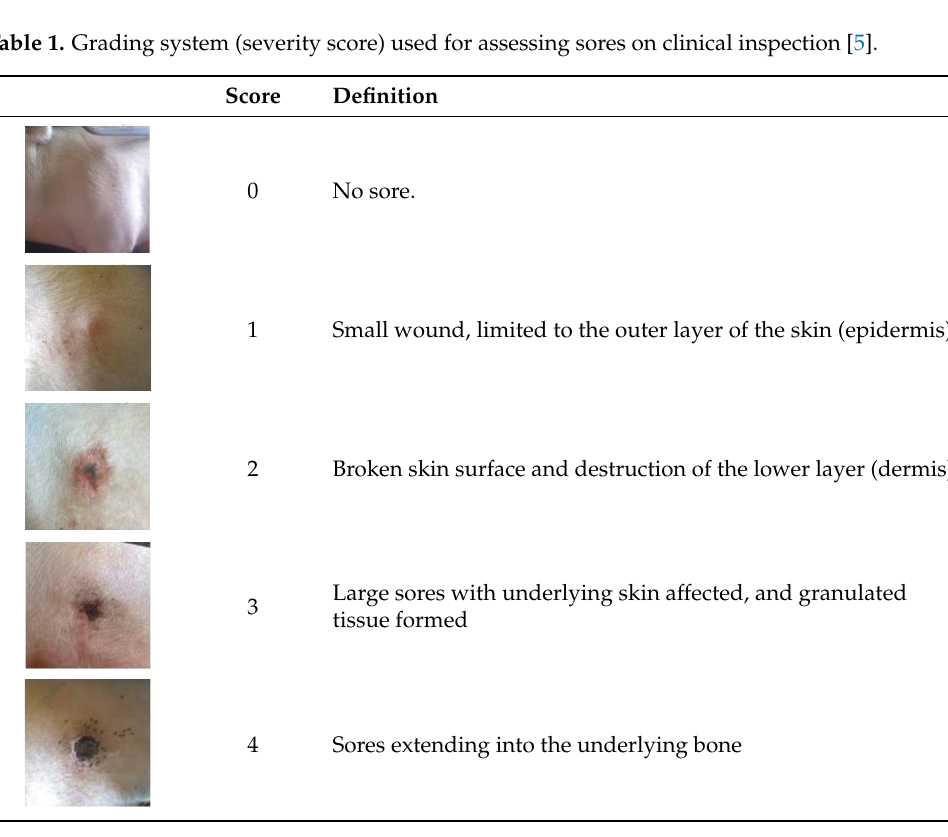
Figure 1. Thermal image of hotspots identified on the shoulder of a sow using FLIR thermal imaging camera.